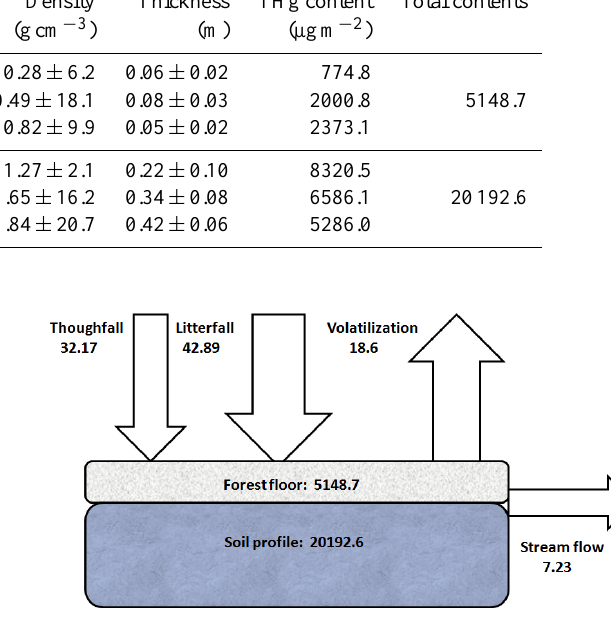
Figure 3. Annual ecosystem Hg fluxes and pools in the evergreen broad-leaf forest field. Fluxes (µgm − 2 yr − 1 ) were represented by arrows, while pools (µgm 2 ) by